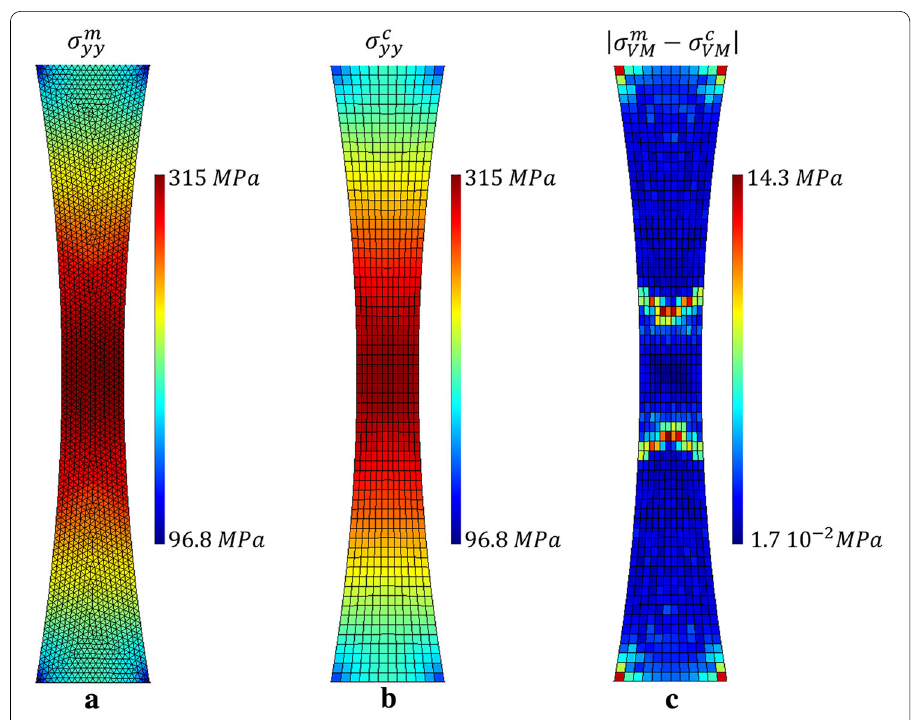
Fig. 6 Distribution of transversal stress fields: a σ m yy from a FE simulation, b σ c yy the identified and c von Mises norm of the absolute error on